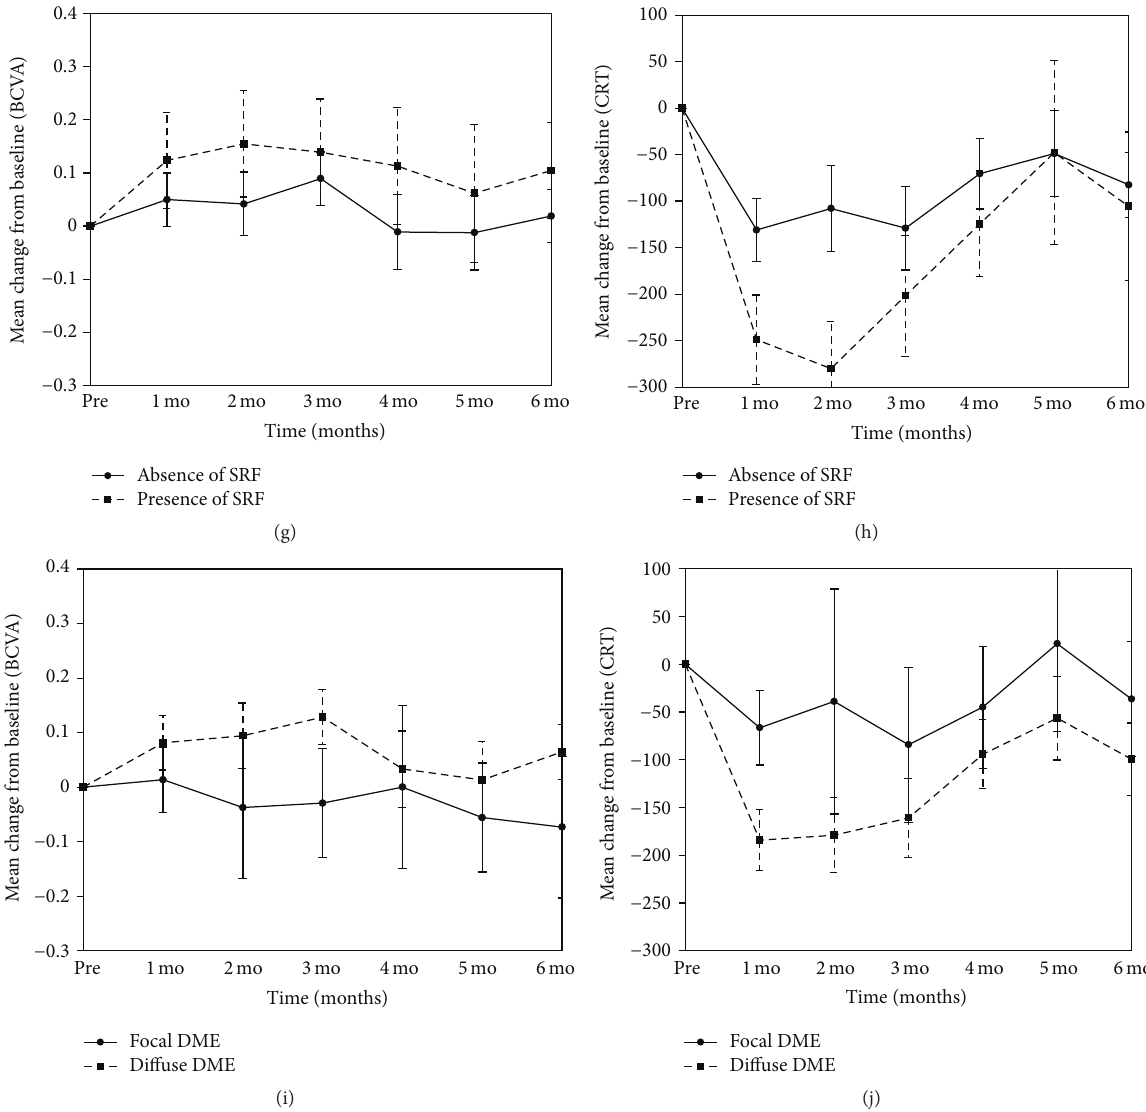
Figure 3: Mean changes from baseline BCVA and CRT in various group analyses. (a) and (b) Treatment na¨ıve versus nonna¨ıve eyes; (c) and (d) phakic versus pseudophakic eyes; (e) and (f) nonvitrectomized versus vitrectomized eyes; (g) and (h) absence of SRF versus presence of SRF; (i) and (j) focal versus diffuse